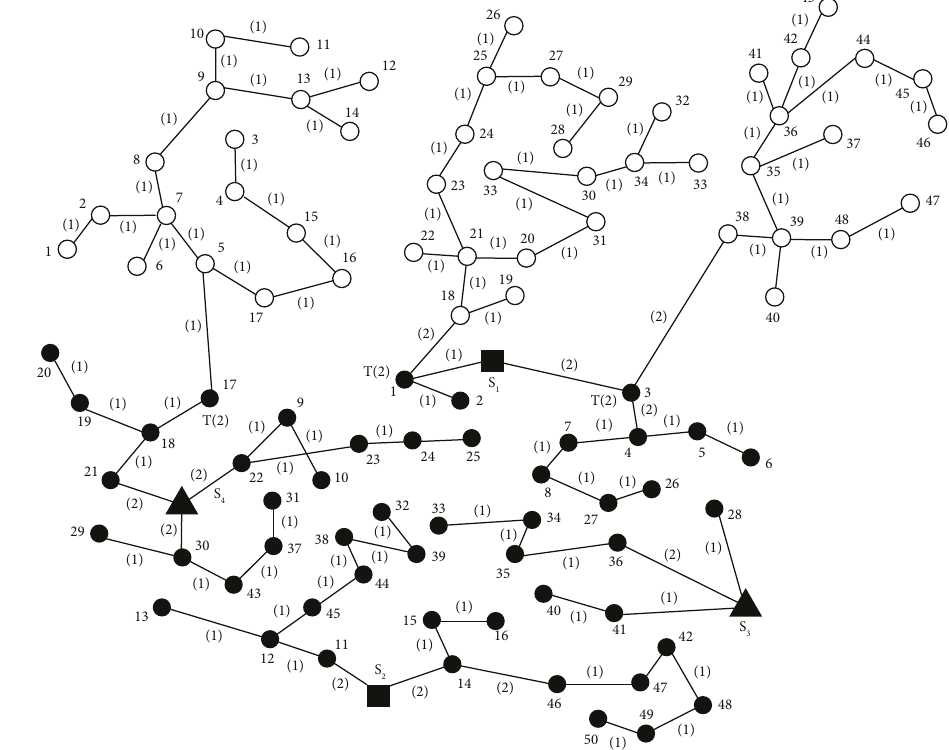
Figure 7: Configuration of the network in case#1.